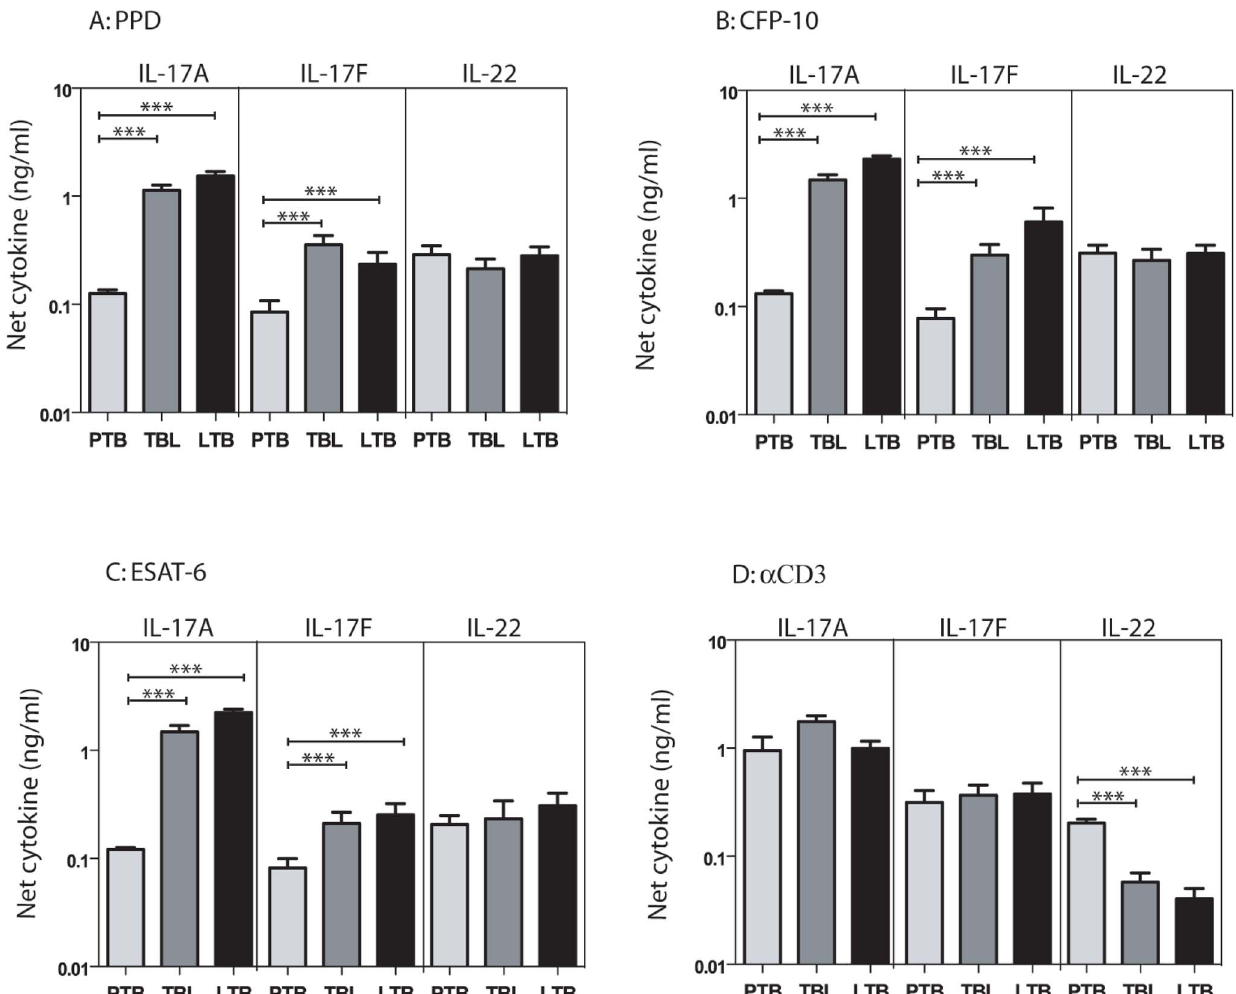
Figure 4. PTB is associated with decreased antigen-stimulated production of Type 17 cytokines. Whole blood from PTB, TBL and LTB individuals was stimulated with (A) PPD (10 m g/ml) or (B) ESAT-6 (10 m g/ml) or (C) CFP-10 (10 m g/ml) or (D) anti-CD3 (5 m g/ml) for 72 h, and levels of Type 17 cytokines IL-17A, IL-17F and IL-22 were measured by ELISA. Results are shown as net cytokine production over media control. The bars represent geometric means and 95% confidence intervals. P values were calculated using the Kruskal-Wallis test with Dunn’s multiple comparisons comparisons (* p , 0.05, ** p , 0.01, *** p , 0.001).